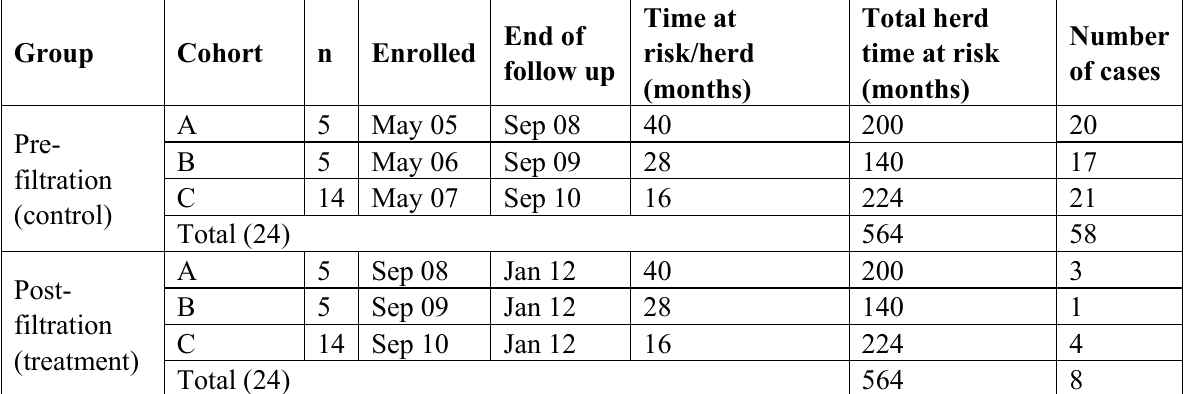
Table 3. Summary of new PRRSV infections before and after air filtration in breeding